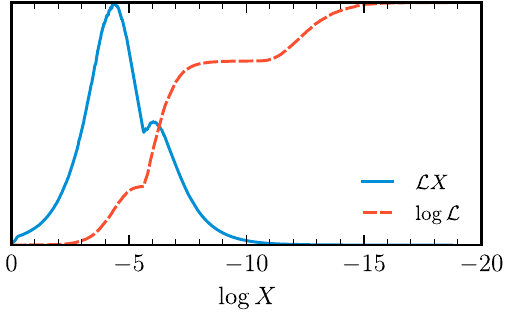
Fig. 3 Likelihood (log L ) and posterior mass ( L X ) profiles for a run of PolyChord on the example target density. The x -axis tracks the prior volume remaining as the run progresses, with log X = 0 corresponding to the start of the run, with the algorithm compressing the volume from left to right, where the run